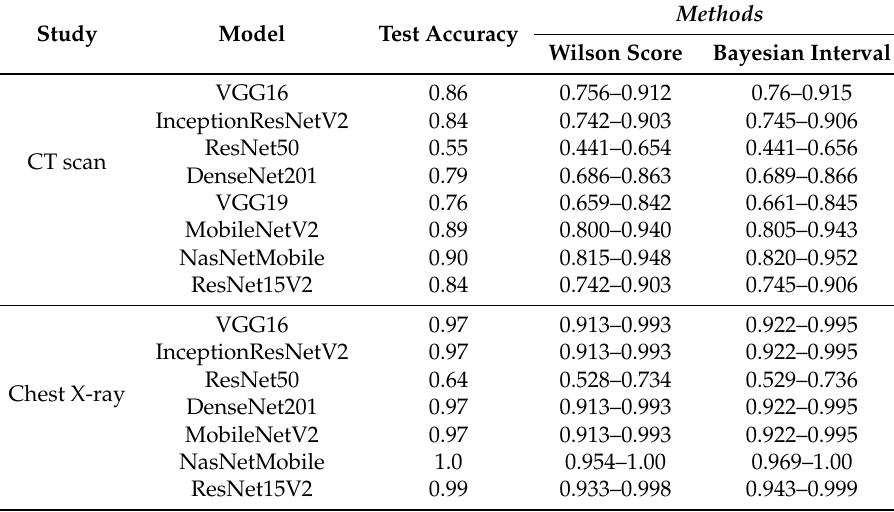
Table 6. Confidence Interval ( α = 0.05) of CT scan and chest X-ray in terms of accuracy on test set. Sample size, n = 80 for both